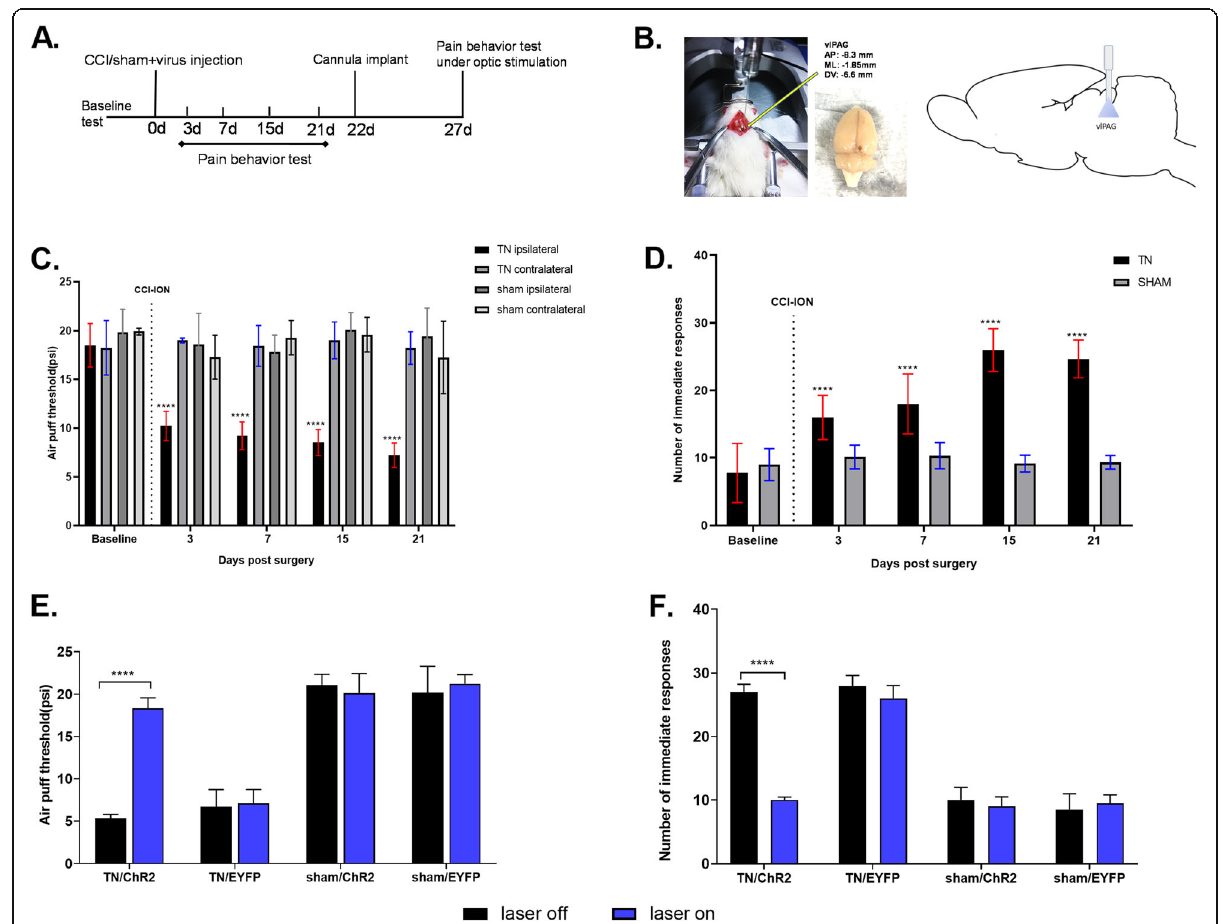
Fig. 3 Pain behavioral alteration observed in TN and sham groups. a Experimental design for pain behavior test and cannula implantation in animal models ( b ) Diagram showing area coordinates for virus injection and optic stimulation. c Air-puff test results for the ipsilateral and contralateral trigeminal facial area. d Cold hyperalgesia results for the ipsilateral facial area following treatment with acetone drops. e Air-puff test scores for the ipsilateral trigeminal facial region under optic stimulation. f Number of immediate responses at the ipsilateral facial area following treatment with acetone drops under optogenetic stimulation in vlPAG. ****, p < 0.0001, significant difference determined via two-way analysis of variance (ANOVA)